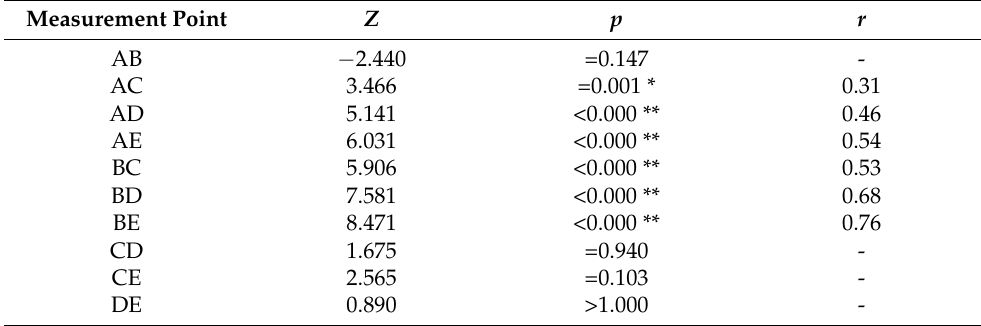
Table A6. Ceramic 5y_DD ( χ 2 (4) = 102.02; p < 0.000); N = 125.